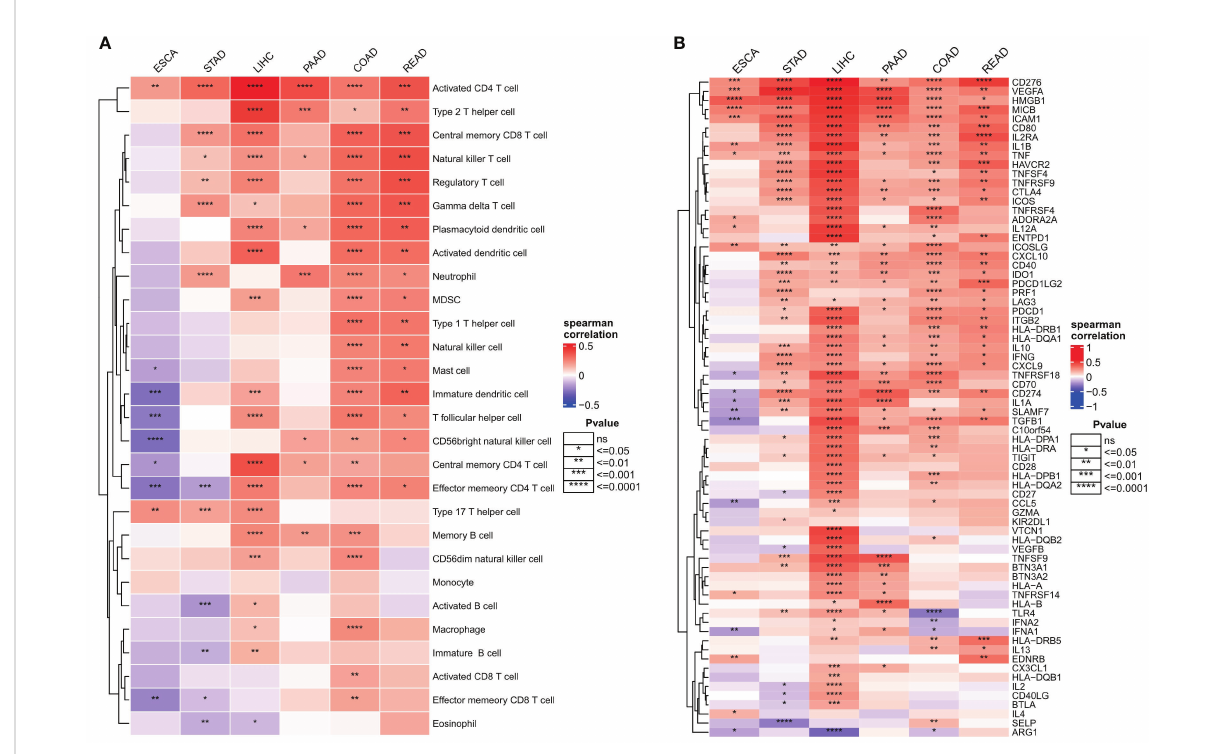
FIGURE 8 Relationship between endoplasmic reticulum stress scores and tumor microenvironment. (A) Spearman ’ s correlation heat map between endoplasmic reticulum stress scores and immune cell in fi ltration scores; (B) Spearman correlation heat map between ER stress scores and immunomodulators. ns, not signi fi cant.